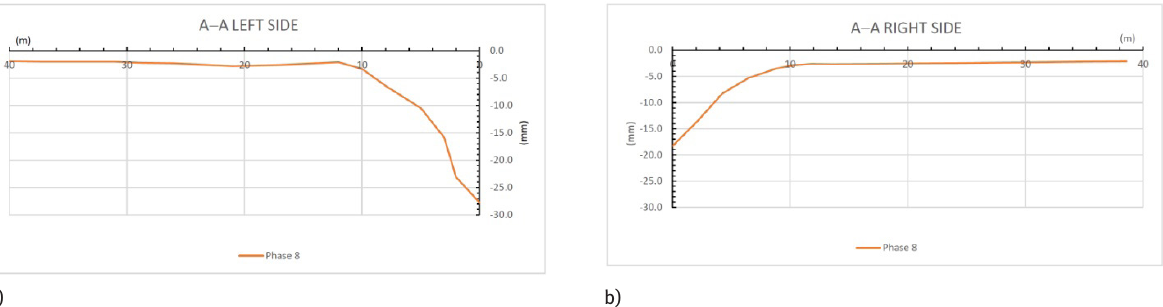
Figure 11: Phase 8 of the implementation – construction of the underground part; graph of vertical displacements of the land surface in the A–A cross section: a) on the left, b) on the right.